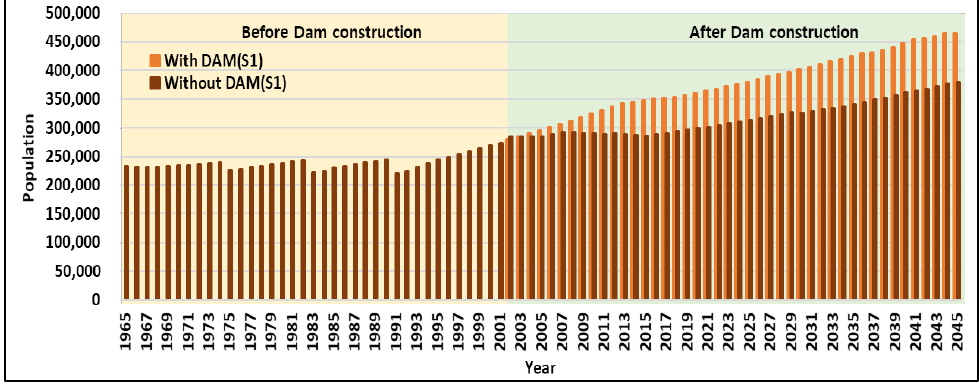
Figure 10. Population comparison between the With DAM and Without DAM simulations for Scenario 1. Gross Regional Domestic Product